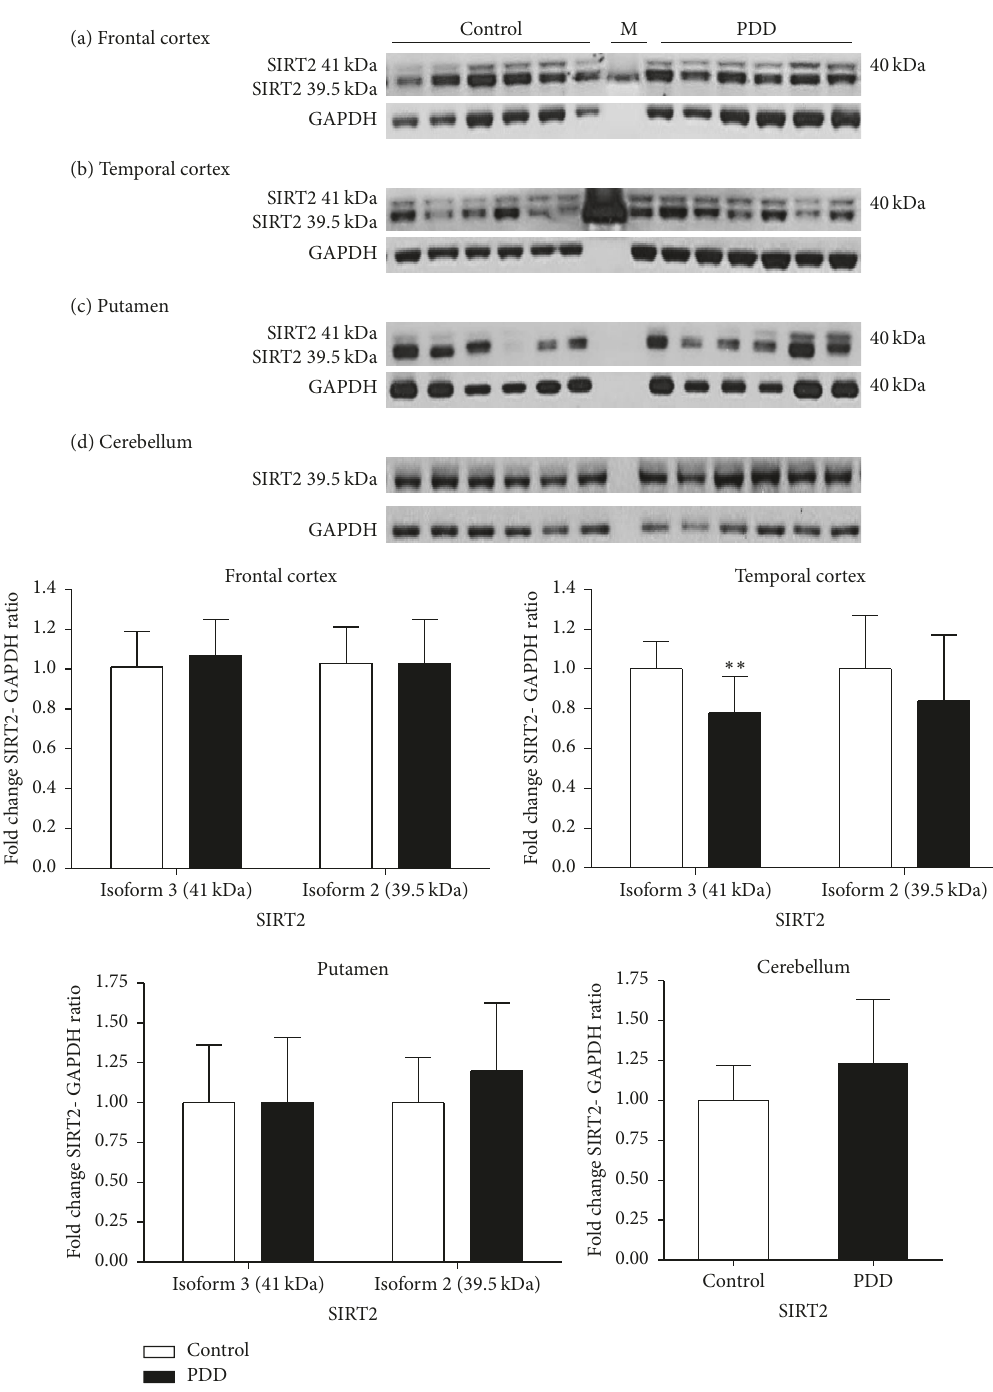
Figure 7: Expression of SIRT2 in different regions in Parkinson’s disease with Dementia. The levels of SIRT2 were determined in different regions of PDD patients and were compared to a control-cohort. SIRT2 band intensity was normalised with GAPDH. Data are presented as fold change ( ± SD) with respect to control from three independent replicates. ∗∗ 𝑝 < 0.01 when compared to control; statistical analysis was done through 𝑡 -test performed on GraphPad prism. Images are representative blots of SIRT2 and GAPDH. M indicates molecular weight marker